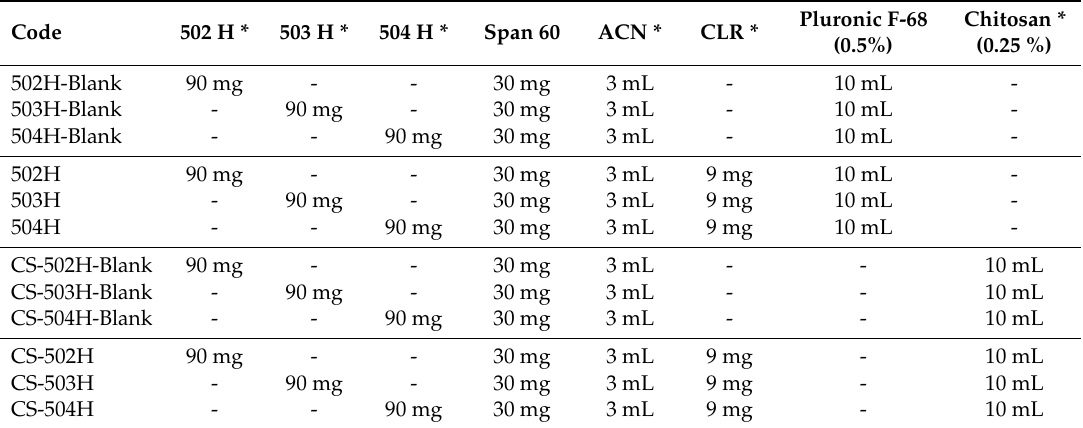
Table 1. Formulation